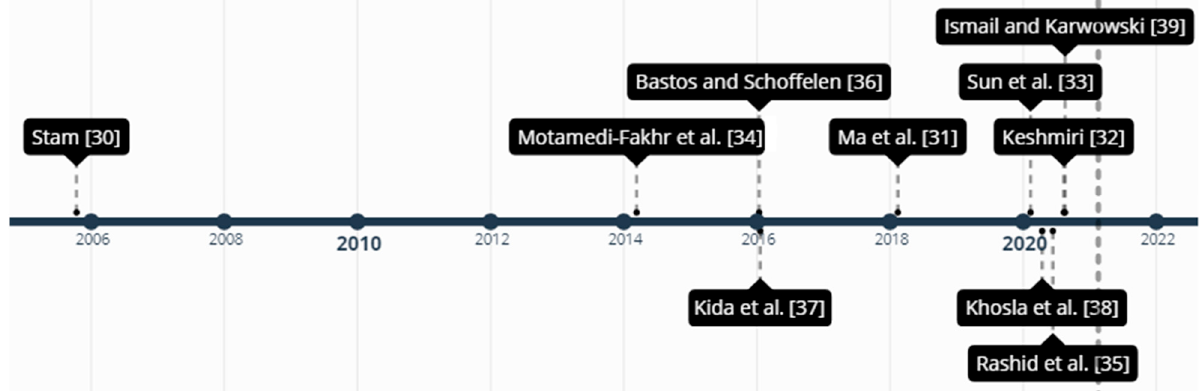
Figure 1. Chronologically ordered reviews of the EEG signal features.